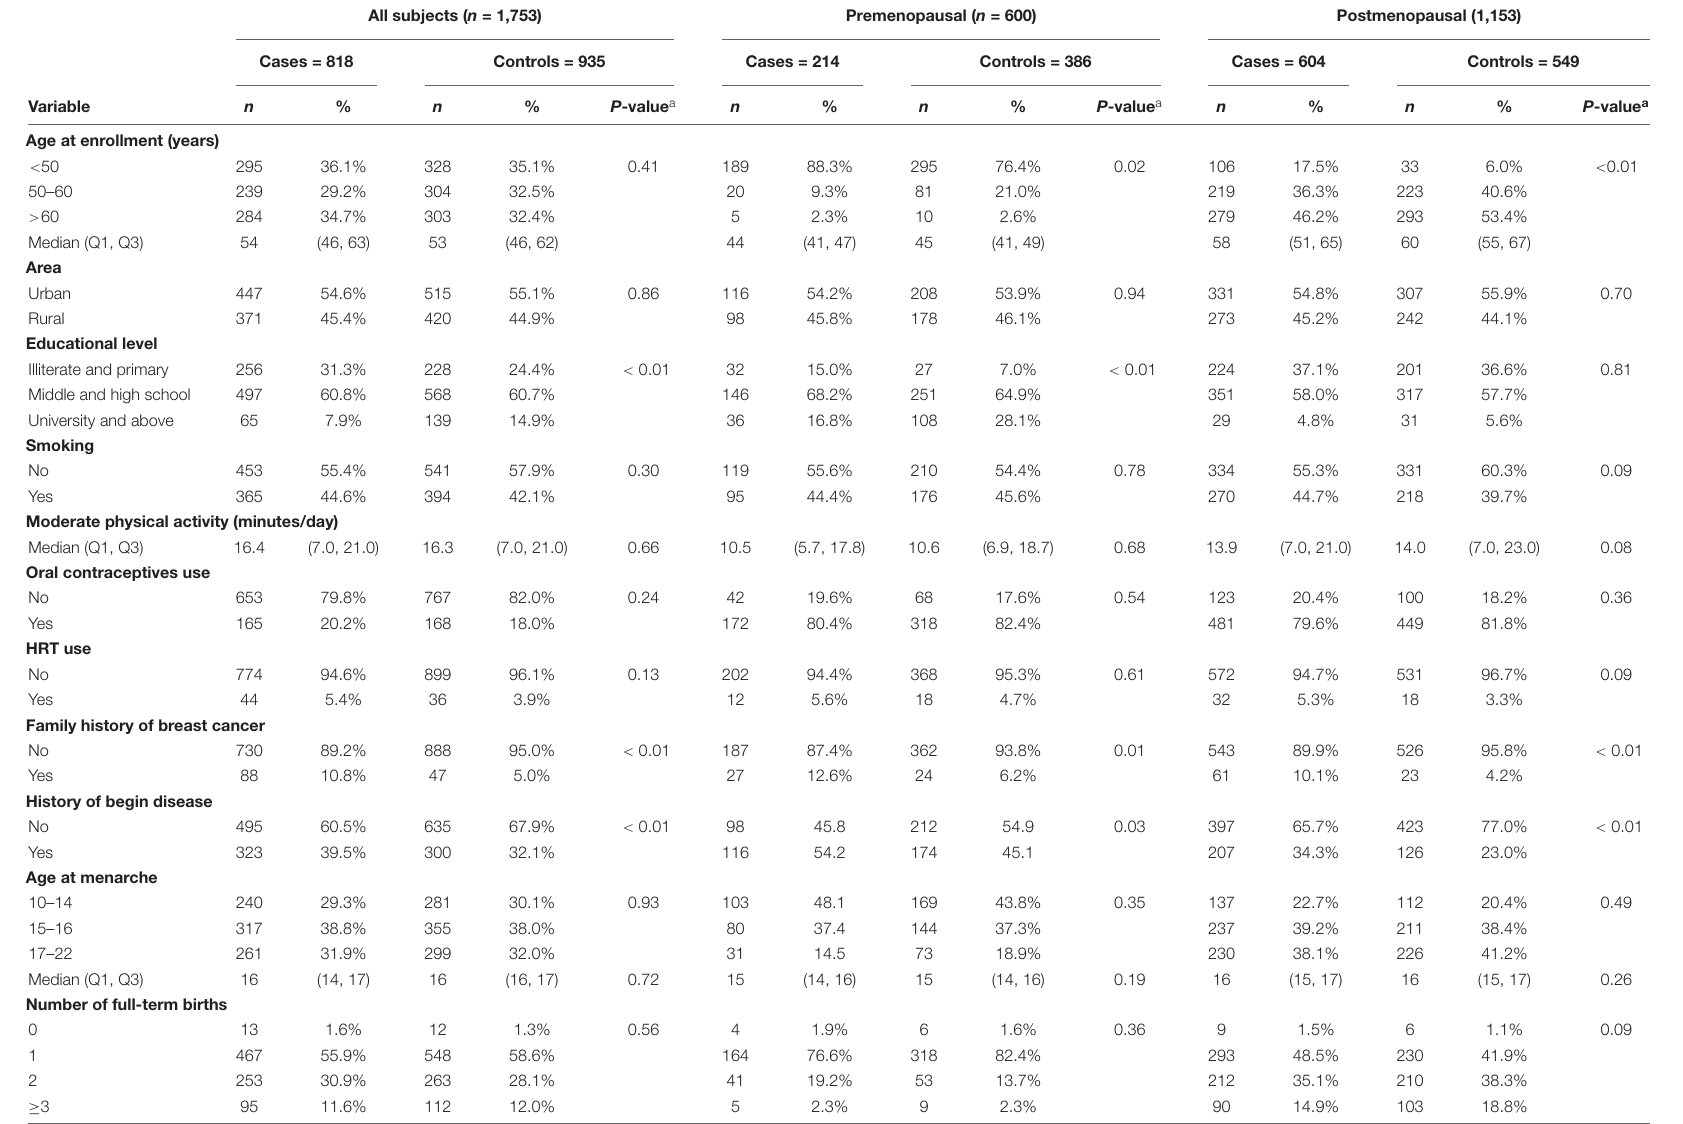
TABLE 1 | Characteristics of subjects for analysis, stratified by menopausal